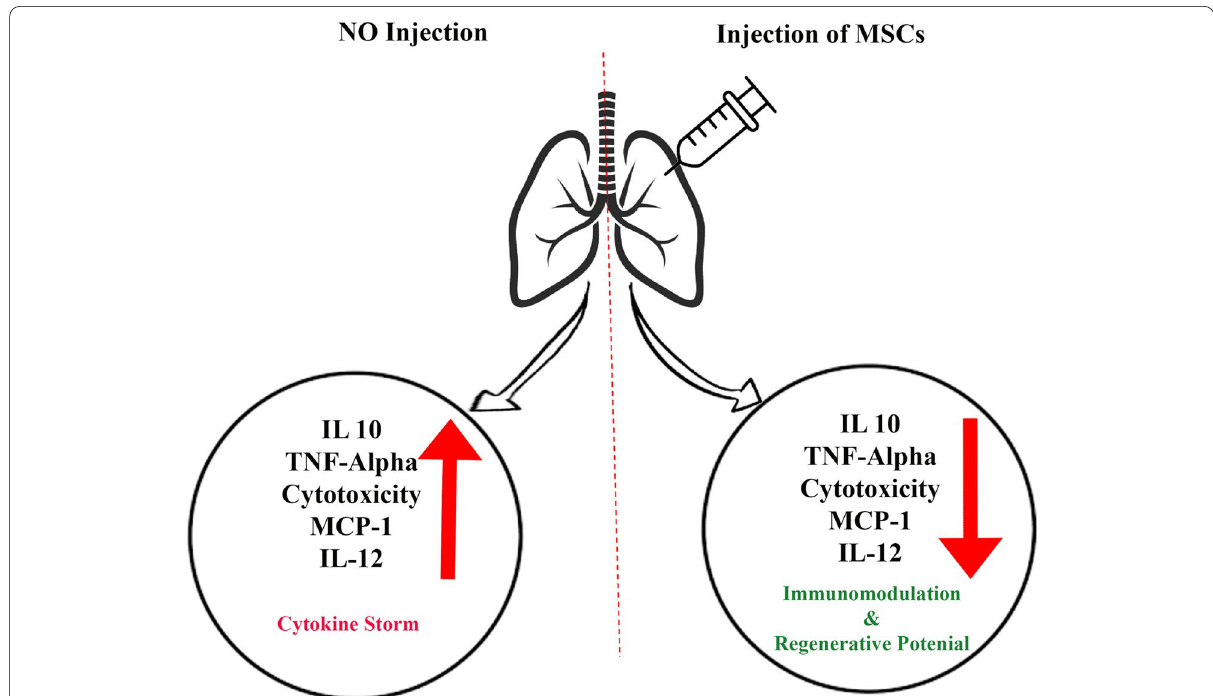
Fig. 3 Effects of Mesenchymal stem cells (MSCs) injection on the patient’s lung. Injection of this cell reduces the secretion of interleukins 10, 12 and MCP-1. Reducing the secretion of these inflammatory factors prevents lung and respiratory diseases such as